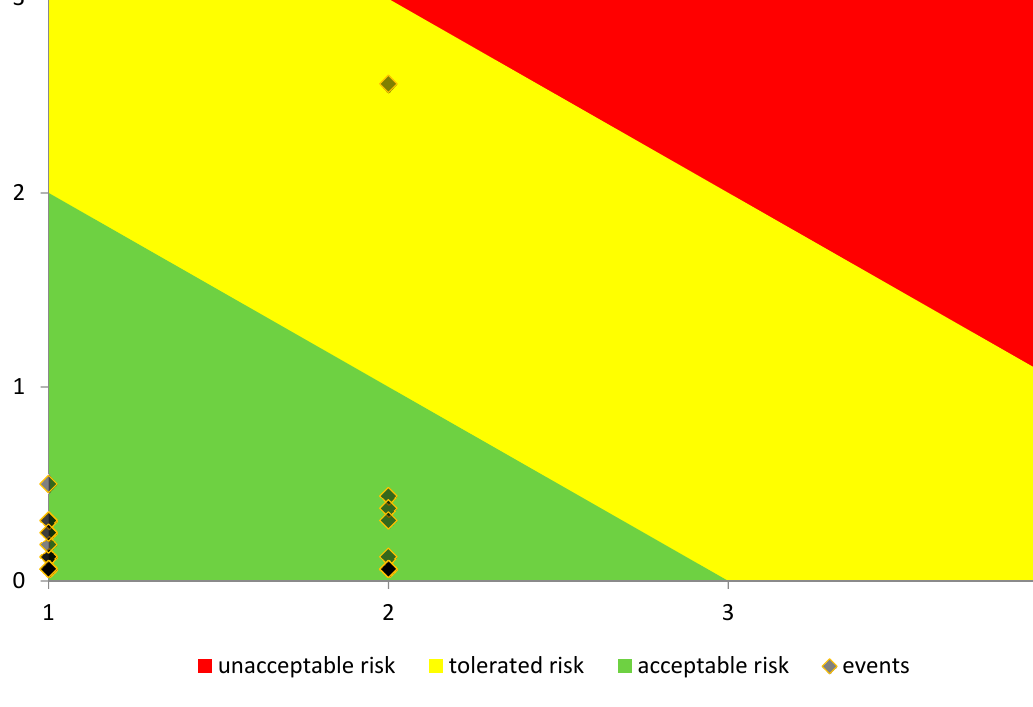
Figure 3. The risk map of the analyzed